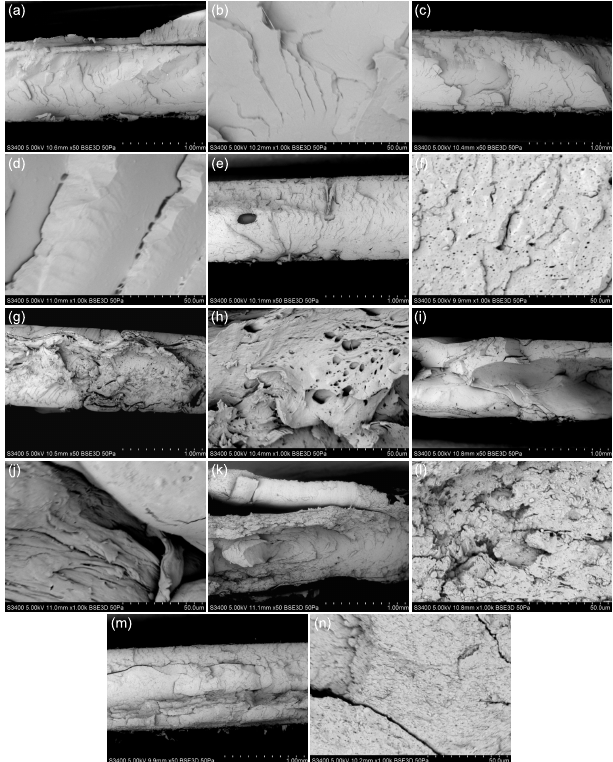
Figure 1. SEM images of fractured surface morphology for ( a ) uuPLA, magnification 50 × g , ( b ) uuPLA, magnification 1000 × g , ( c ) upPLA, magnification 50 × g , ( d ) upPLA, magnification 1000 × g , ( e ) PLA-FG, magnification 50 × g , ( f ) PLA-FG, magnification 1000 × , ( g ) SiO 2 L-PLA-FG-1, magnification 50 × g , ( h ) SiO 2 L-PLA-FG-1, magnification 1000 × g , ( i ) SiO 2 L-PLA-FG-5, magnification 50 × g , ( j ) SiO 2 L-PLA-FG-5, magnification 1000 × g , ( k ) SiO 2 L-PLA-FG-10, magnification 50 × g , ( l ) SiO 2 L-PLA-FG-10, magnification 1000 × g , ( m ) SiO 2 L-PLA-FG-15, magnification 50 × g , and ( n ) SiO 2 L-PLA-FG-15, magnification 1000 × g